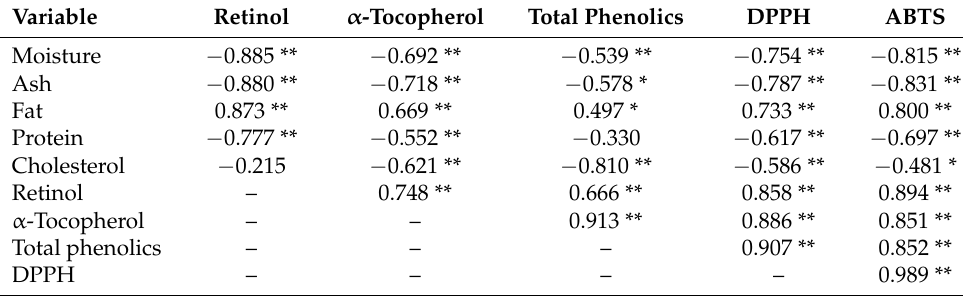
Table 3. Coefficients of Pearson’s correlation (n = 35).